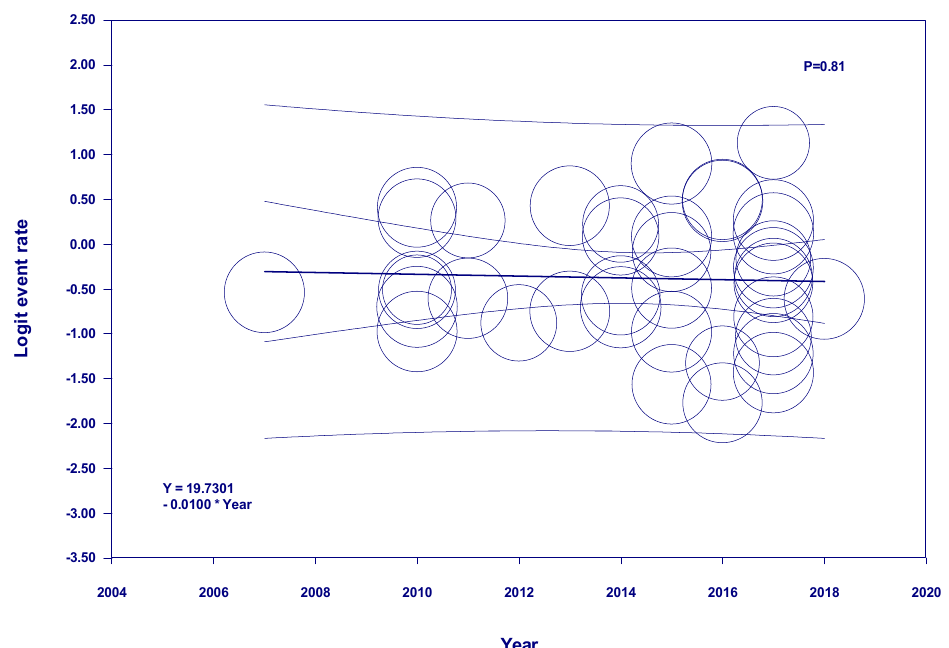
Figure 4. Meta-regression analyses showed no significant impact of year of study on the incidence of post-LTx AKI ( p = 0.81). The solid black line represents the weighted regression line based on variance-weighted least squares. The inner and outer lines show the 95% confidence interval and prediction interval around the regression line. The circles indicate log event rates in each study.